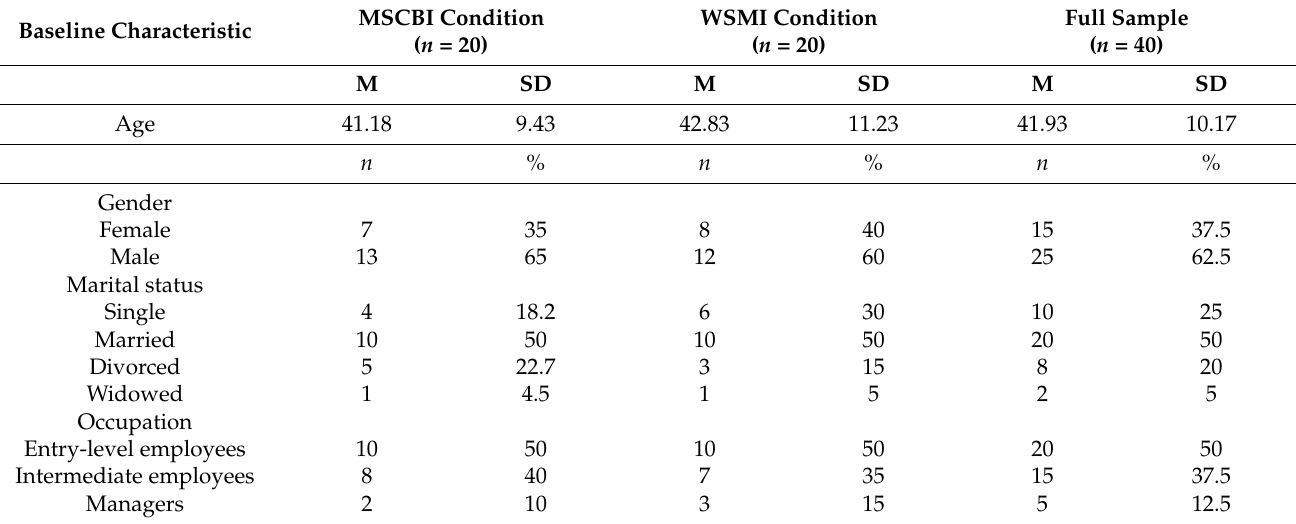
Table 1. Characteristics of study